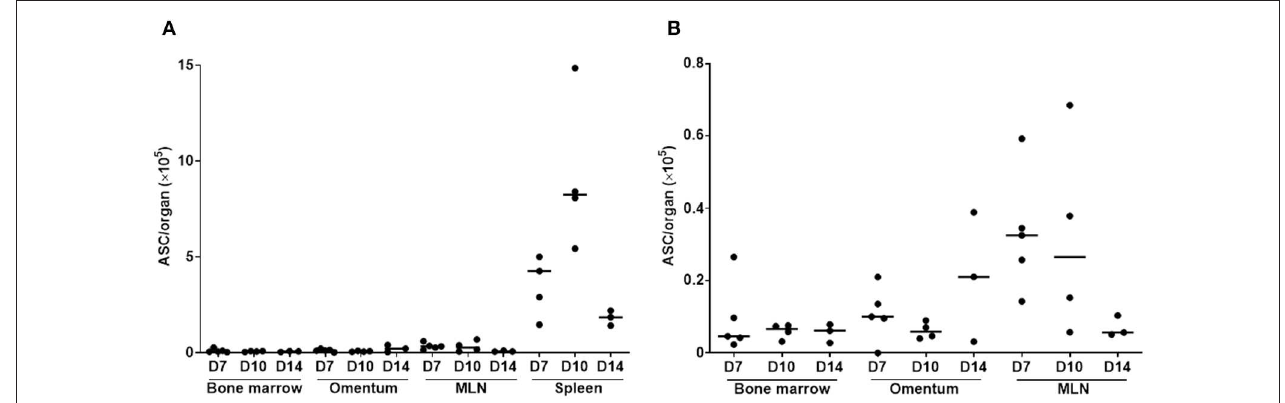
FIGURE 2 | Antibody-secreting cells in lymphoid organs after sepsis. Sepsis was induced by CASP-operation in female C57BL/6 mice. At the indicated time points bone marrow, omentum, mesenteric lymph nodes (MLN) and spleen were harvested and cells isolated. Antibody-secreting cells (ASC, sum of IgM and IgG) per organ were measured with an ELISpot, and the median is depicted (A) . ASC/organ values below 1 × 10 5 for bone marrow, omentum and MLN are separately shown (B) . N = 3–5.